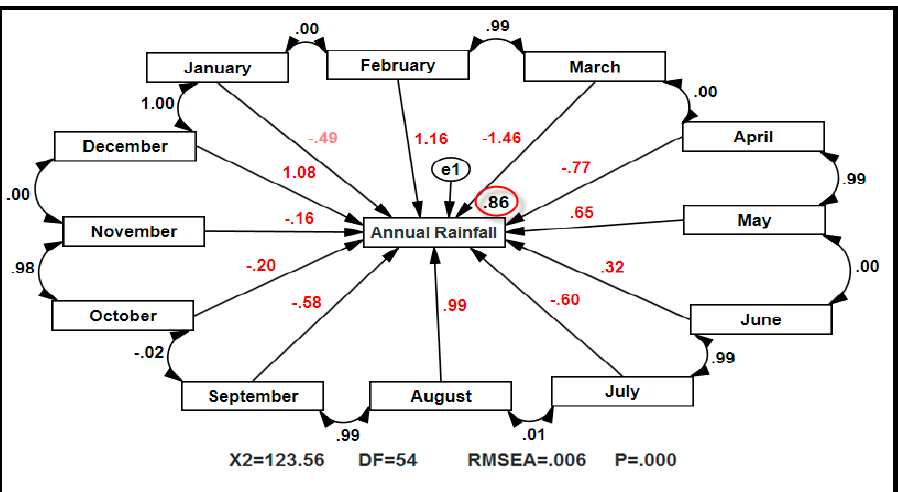
Figure 12. The effectiveness analysis between the monthly temperatures and annual rainfall. Effectiveness model analyzed casually in each climatic series. The single-headed arrows denote causal relationships and the impact of one variable on another; the double-headed arrows indicate covariance or correlation between pairs of variables. The SEM model shows that monthly temperatures have a direct effect (red data) on annual rainfall. Monthly temperatures have direct effects (positive and negative) on annual rainfall and monthly temperatures have a correlation with neighborhood series. An error term (e1) is associated with an observed variable (annual rainfall). In the model summary presented in Figure 12, the overall chi-square ( χ 2 ) value, together with its degrees of freedom and probability value was observed.